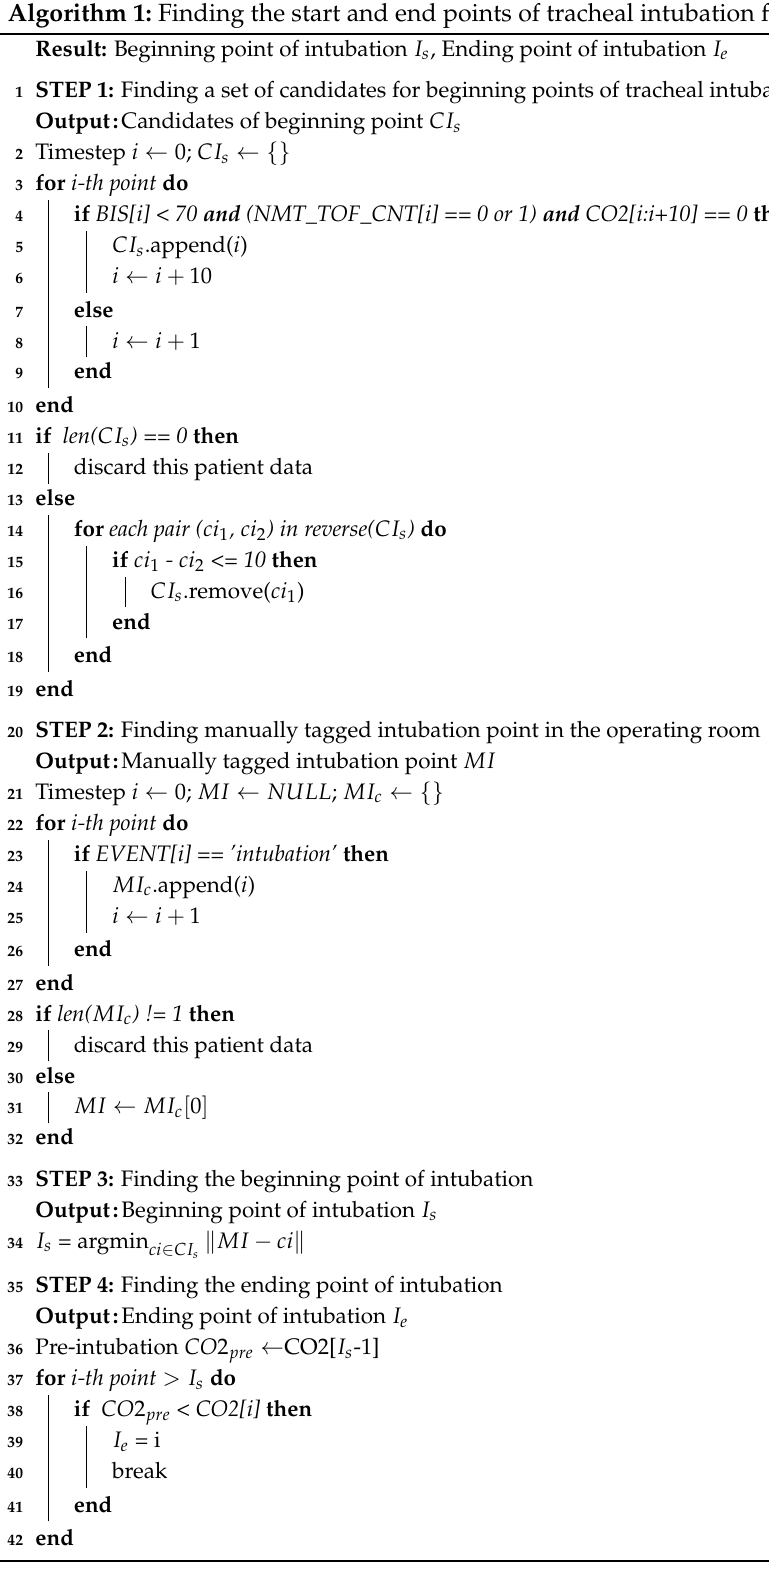
Algorithm 1: Finding the start and end points of tracheal intubation for a target patient. Result: Beginning point of intubation I s , Ending point of intubation I